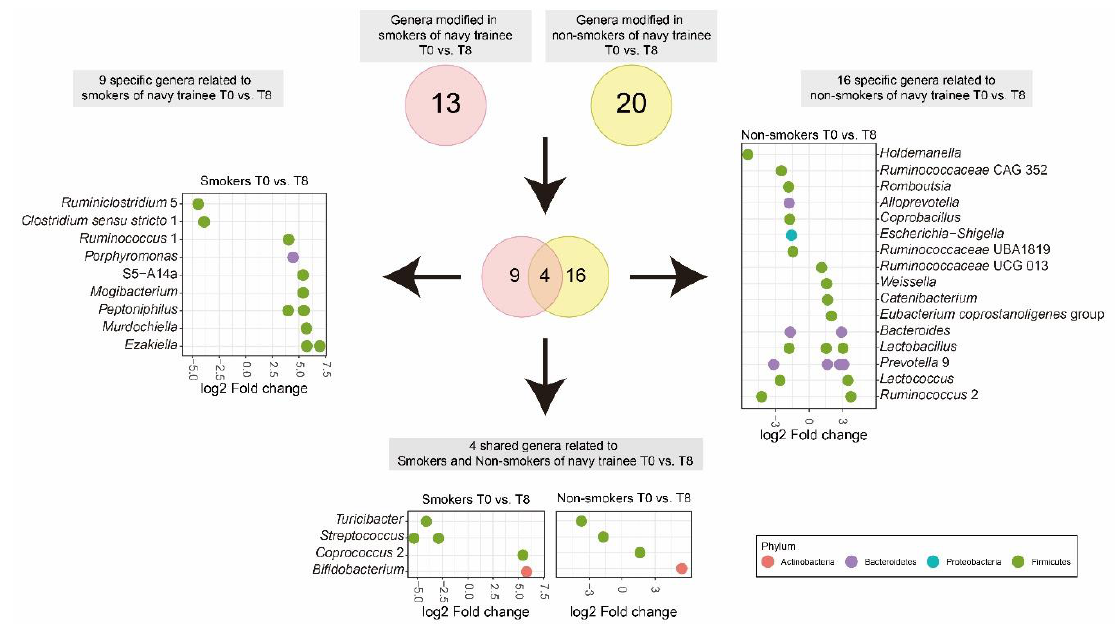
Figure 3. Venn diagram and Log2 fold change in the relative abundance of specific genera in smokers and non-smokers of the navy trainee group. Note: smokers had stopped smoking for eight weeks.